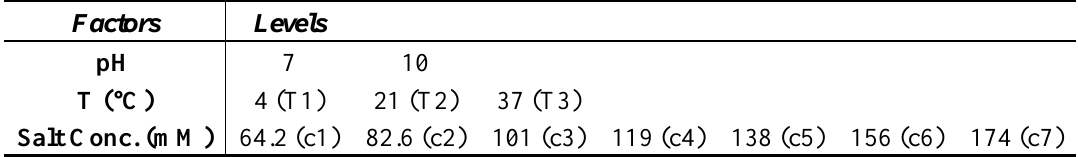
Table 1. Experimental plan for the preparation of collagen gels. Samples were prepared combining each level of each of the three factors: pH, temperature and ionic strength. The levels of ionic strength were defined by modulating the salt